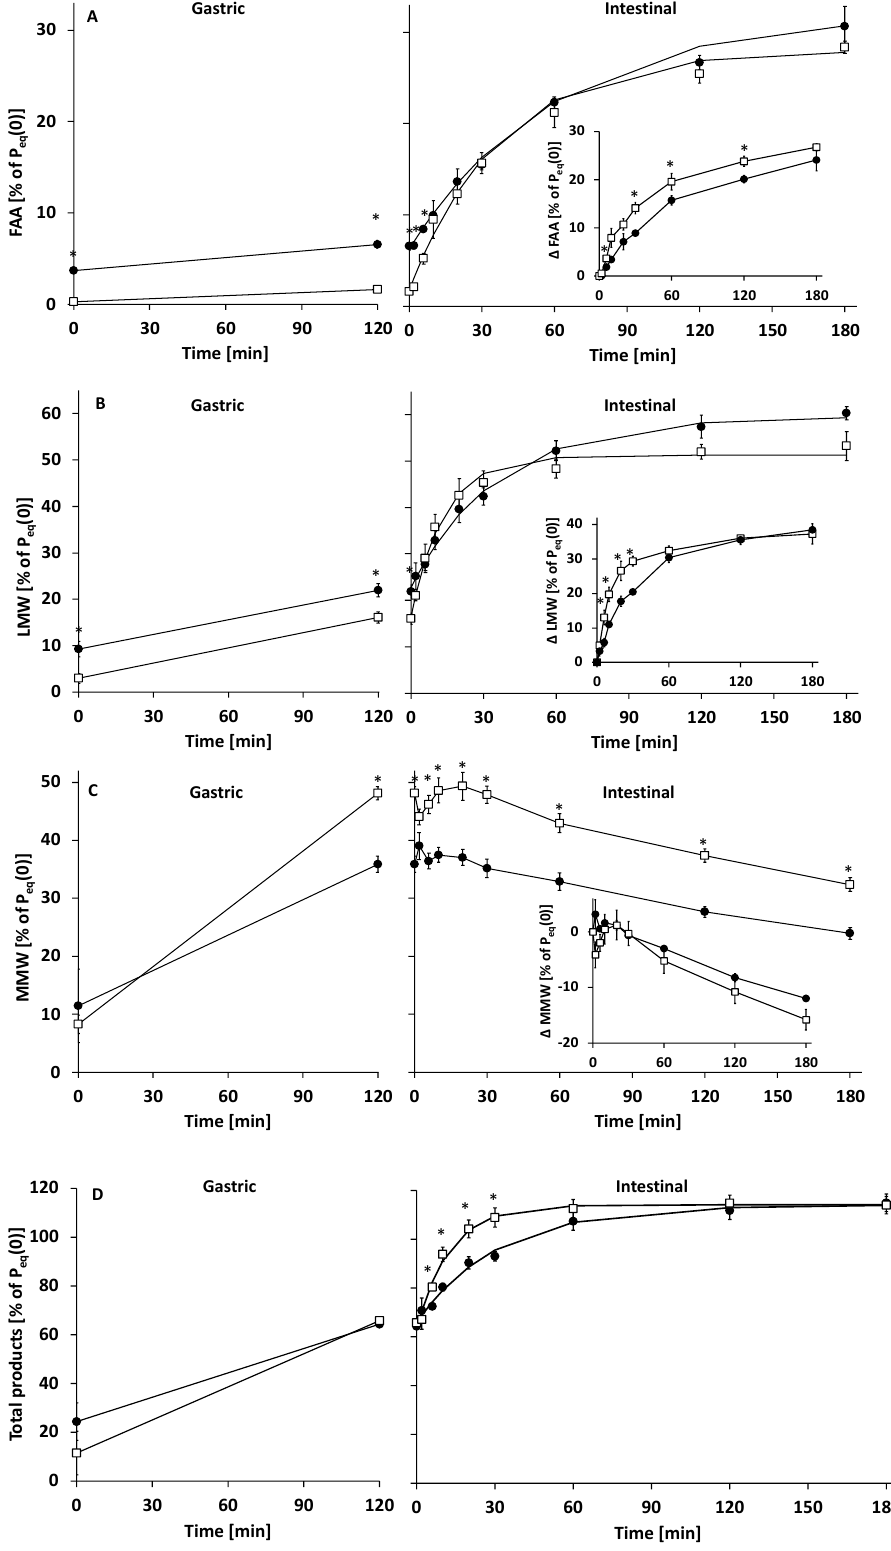
Figure 7. Protein digestion products of human milk (HM, ( • ) and infant formula (IF, ) in time, expressed as weight percentage of protein equivalent in the respective infant milk (% of P eq (0)). ( A )